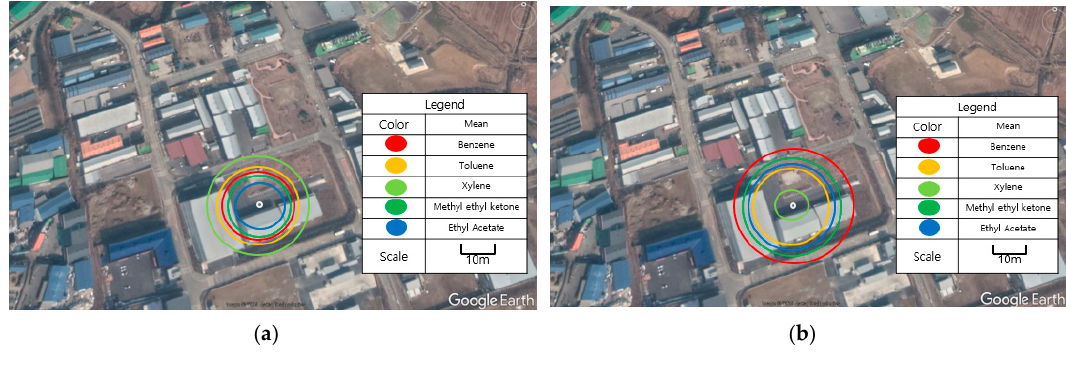
Figure 2. Damage radius of a ( a ) pool fire and ( b ) VCE.